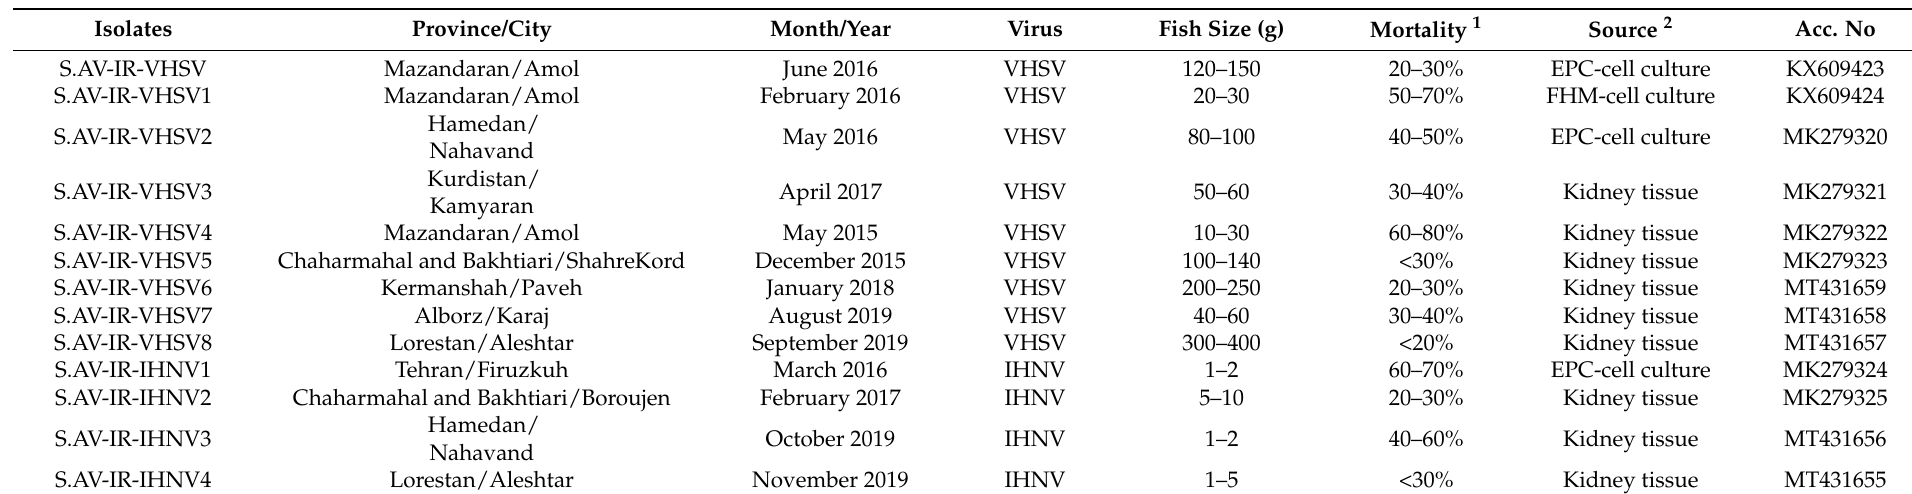
Table 1. Details of VHSV and IHNV outbreaks in farmed rainbow trout ( O. mykiss ) included in this study.